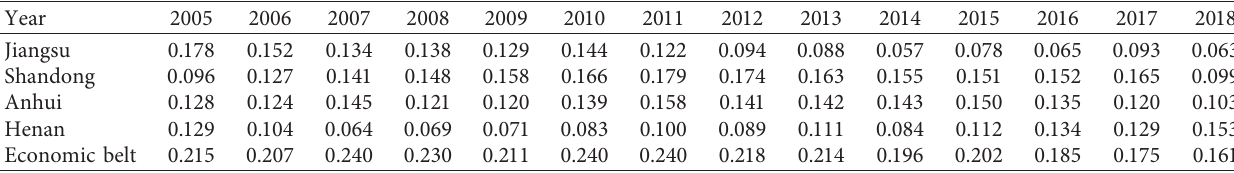
Table 5: The α -value of the urban competitiveness of the Huaihe eco-economic belt.